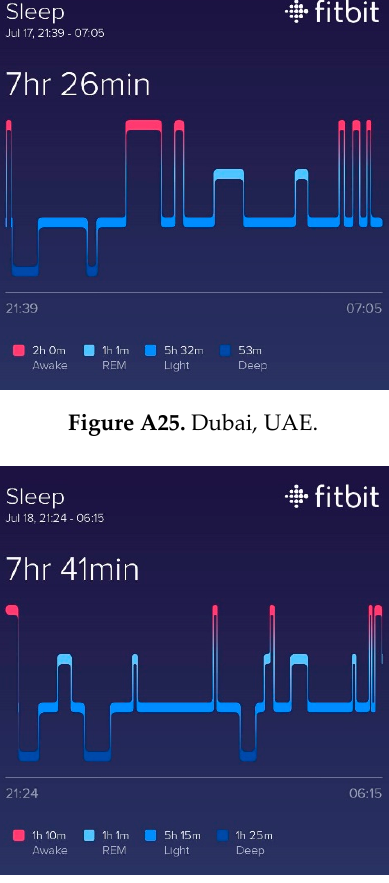
Figure A26. Dubai, UAE.